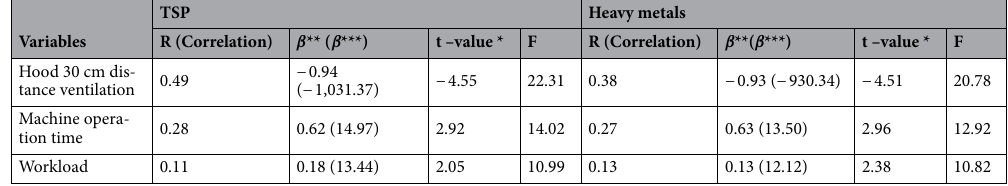
Table 2. Multiple linear regression on TSP and heavy metals concentrations and environmental factors. *p < 0.05. **Standardization factor. ***Non-standardization